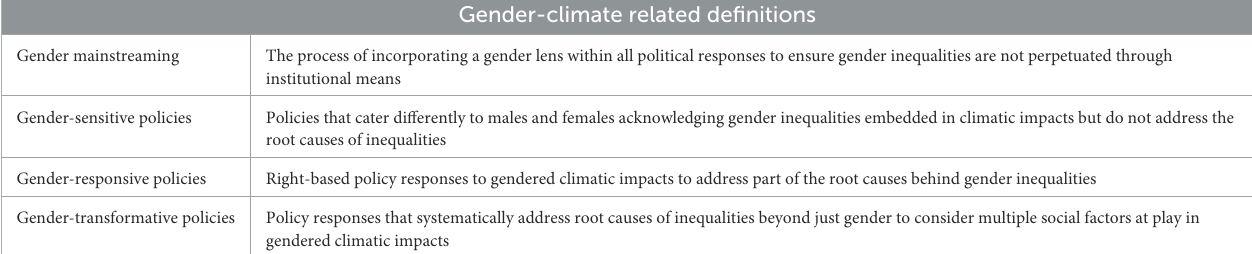
Gender-climate related definitions